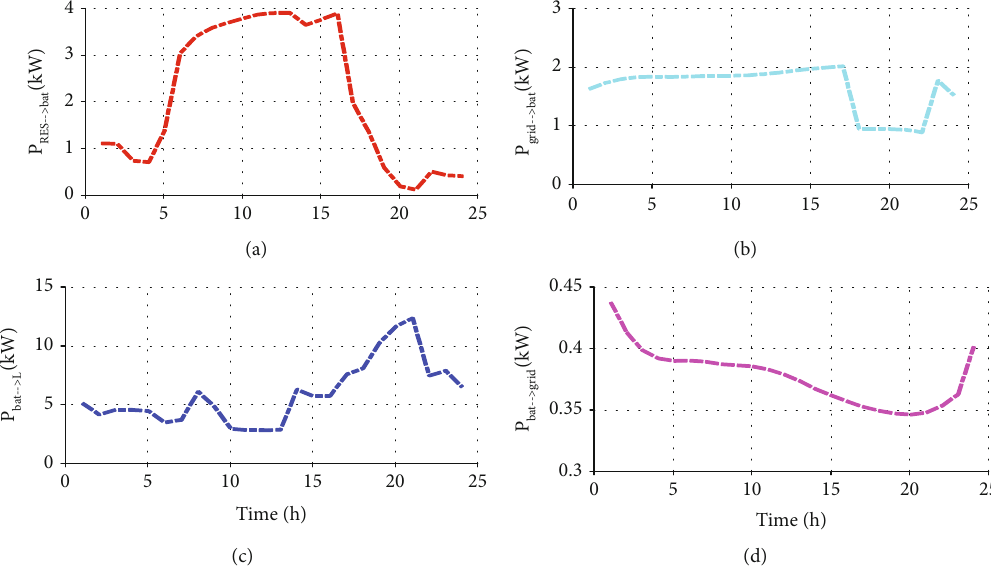
Figure 9: (a) Produced power from RES to charge the battery; (b) imported power from the utility grid to the battery; (c, d) discharged power from battery system to the load and grid,